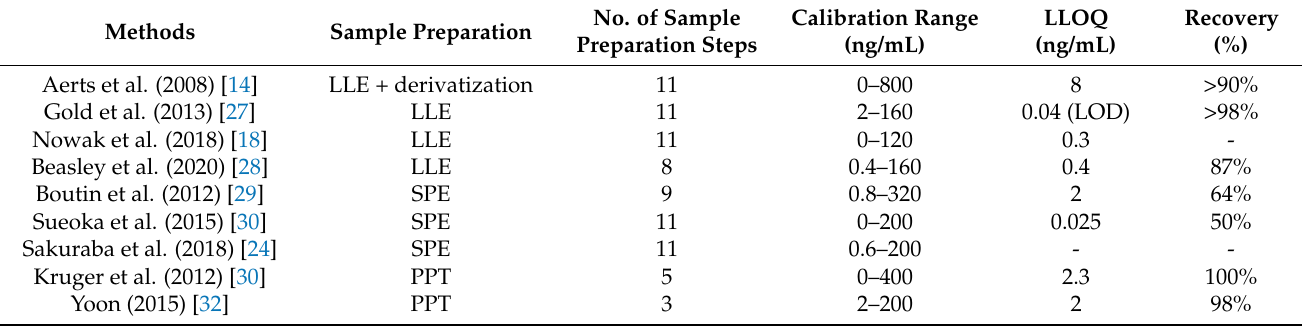
Table 4. List of published methods for lyso-Gb3